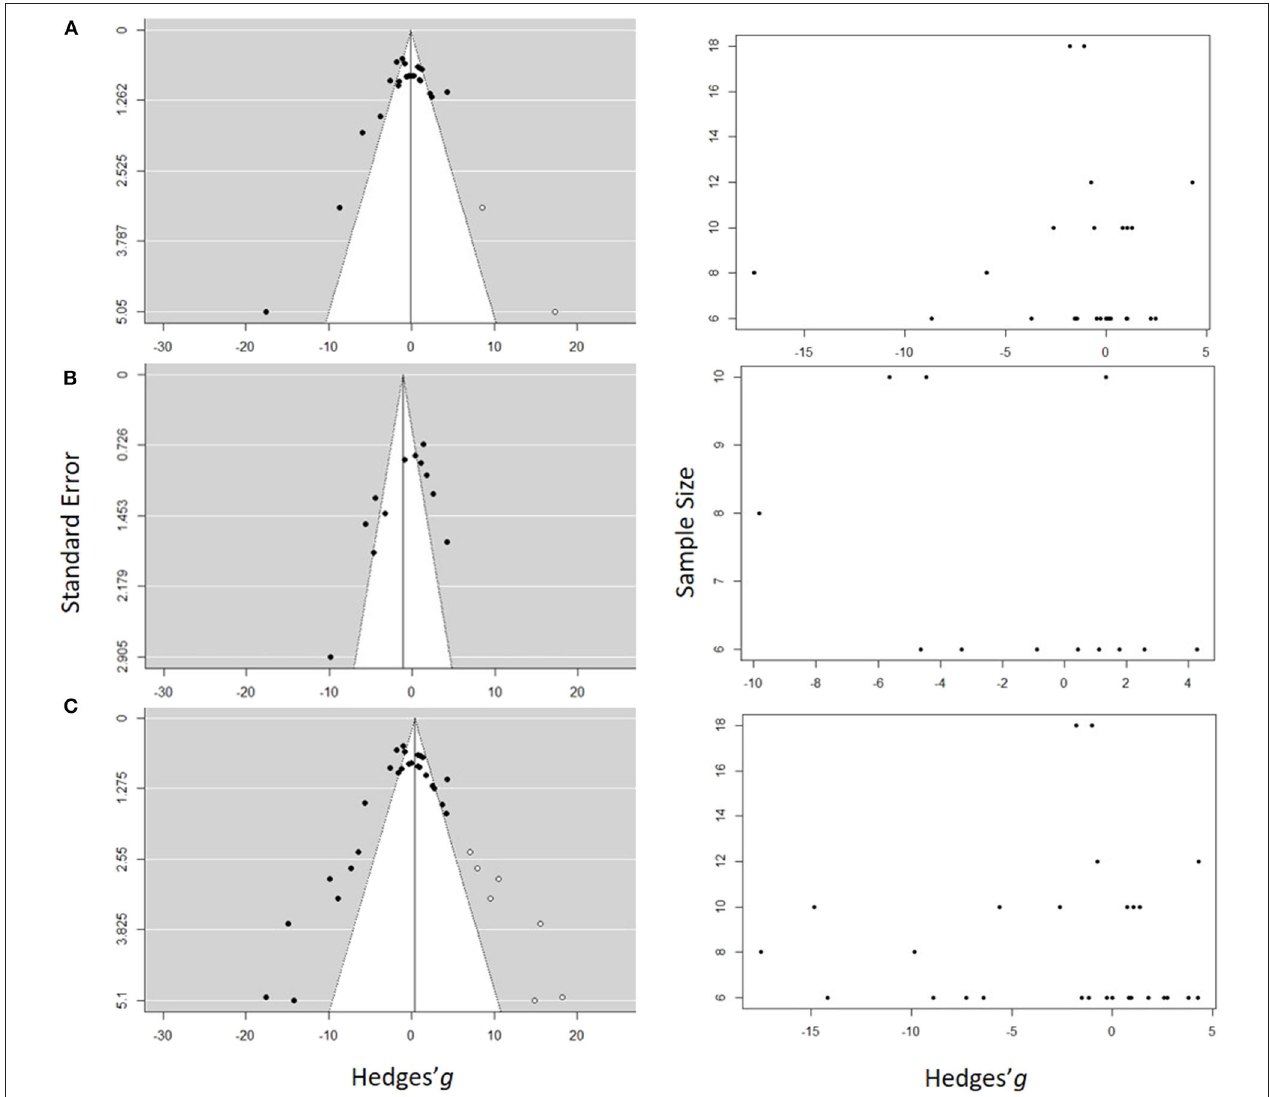
FIGURE 7 | Funnel plots estimating probability of a publication bias for the studies used in the meta-analysis for (A) Low concentration model , (B) High concentration model, and (C) Full range model . In the panels on the left side, the standard error is plotted against the effect size (Hedges’ g ), and in the panels on the right side, the sample size is plotted against the effect size. Each dot represents an entry in the model. The hollow symbols in the funnel plots are the studies filled by the trim-and-fill procedure, which would balance out the asymmetry of the funnel. The white area in the funnel plots depicts the significance with 0.05 < p for 0.00 < p ≤